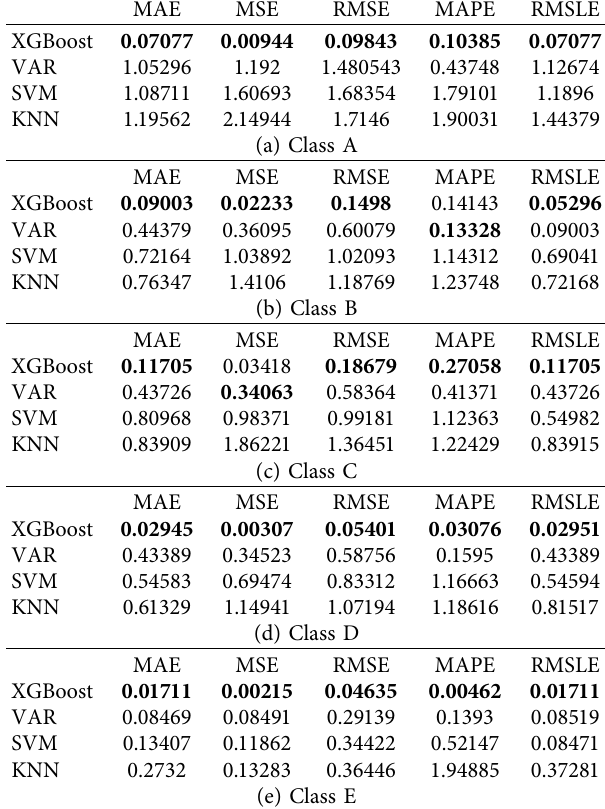
Table 9: Deep learning for historical data with weekends data evaluation results.